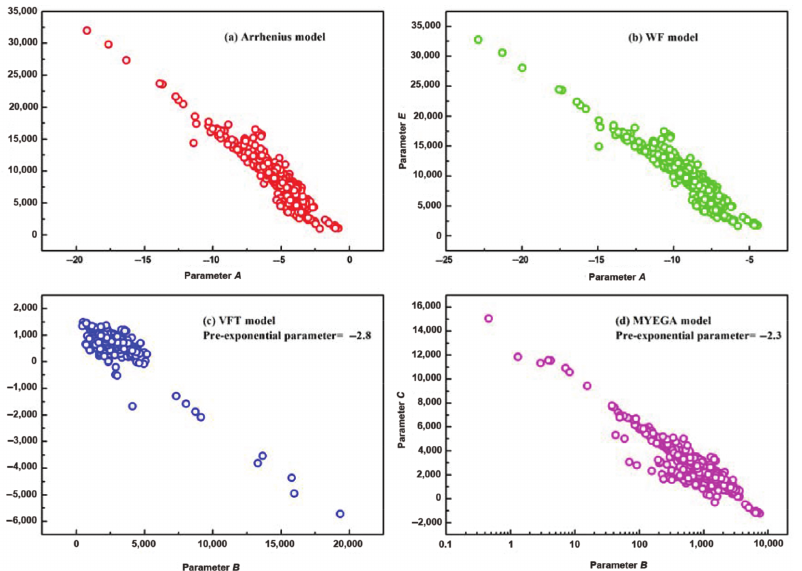
Figure 4: Relationship between fitted variables for two-variable models: (a) Arrhenius, (b) WF, (c) VFT with constant pre-exponential parameter, (d) MYEGA with constant pre-exponential parameter.